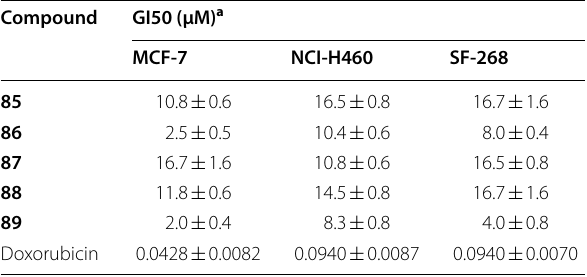
activity GI50 (μM)